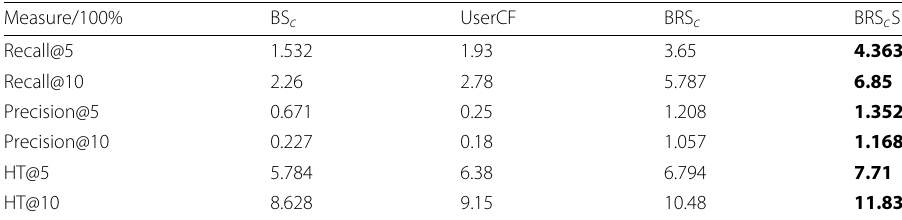
Table 4 Experiment II of